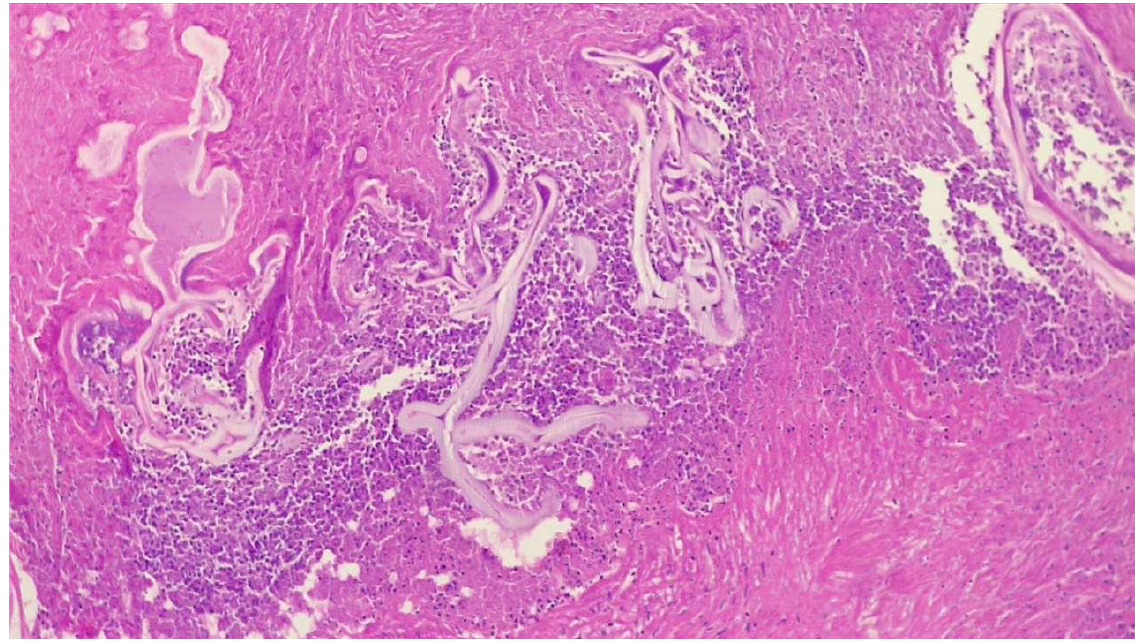
Figure 4. Histopathological specimen of case 1. Multiple cystic cuticular structures surrounded by abundant necrotic tissue and inflammatory reaction. Other areas showed in addition granulation tissue and fibrosis (H&E staining, 100×).